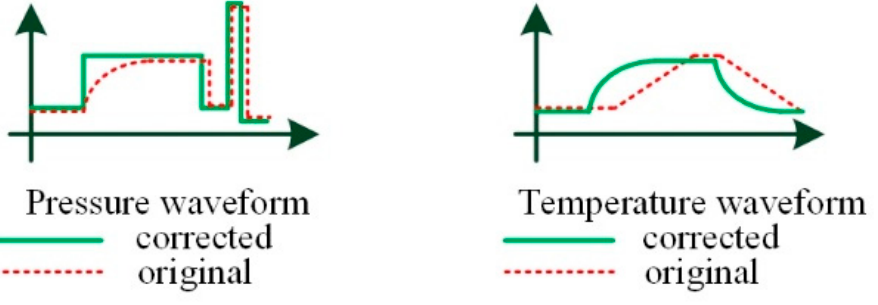
Figure 5. Examples of context-based data quality problems, covered by context-based data analysis part of the quality assurance approach.